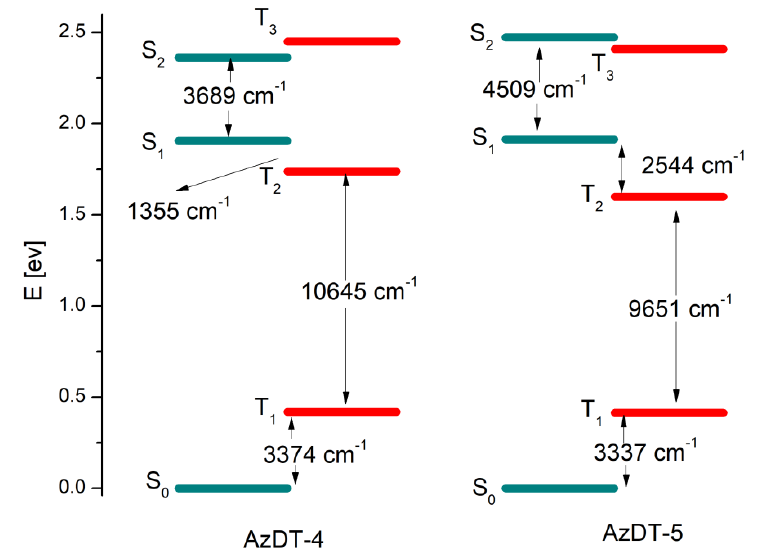
Figure 3. Low-lying energy states of AzDT-4 and AzDT-5 molecules.